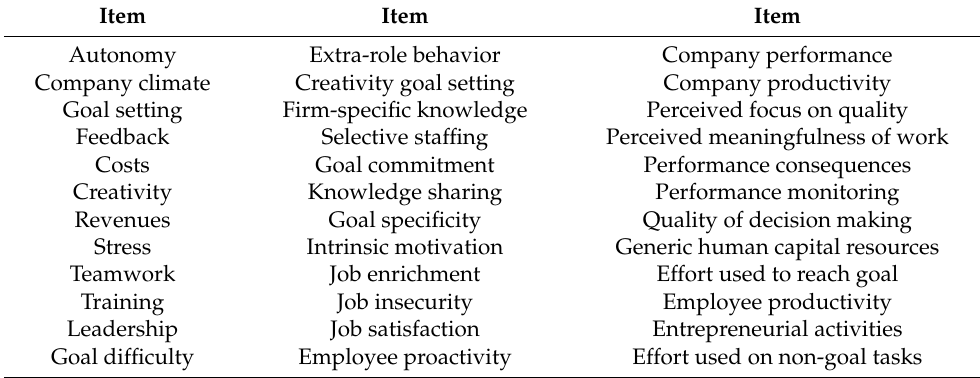
Table 5. Items in Figure 9 on the synthesized